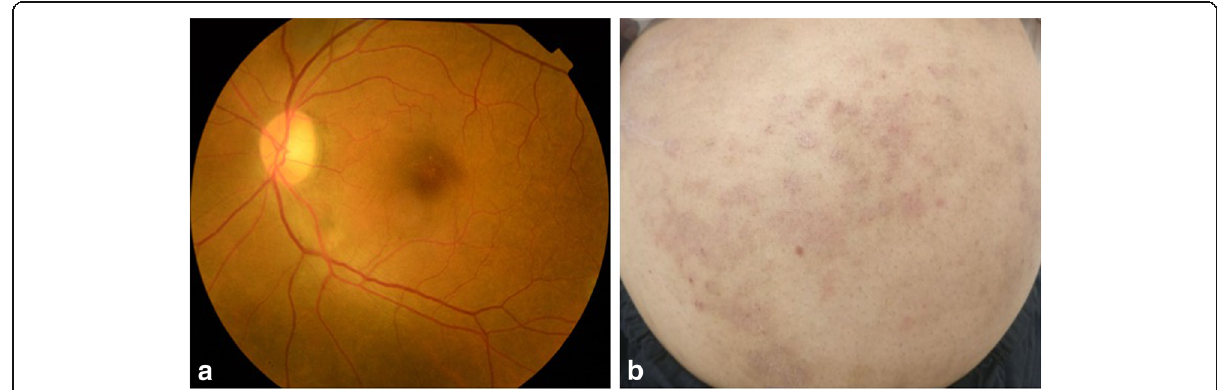
Fig. 5 a Fundus photograph of the left eye showing resolving retinochoroiditis lesion. b Color photograph of the abdomen showing resolving skin lesions. (Second week)